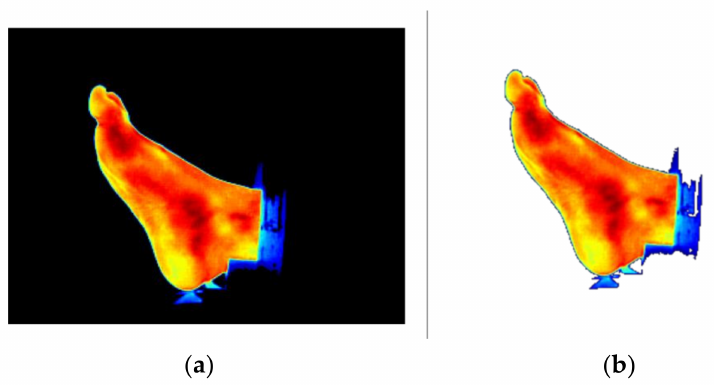
Figure 16. Illustration of the transparency process. ( a ) IR image with a black background and ( b ) IR image with a transparent